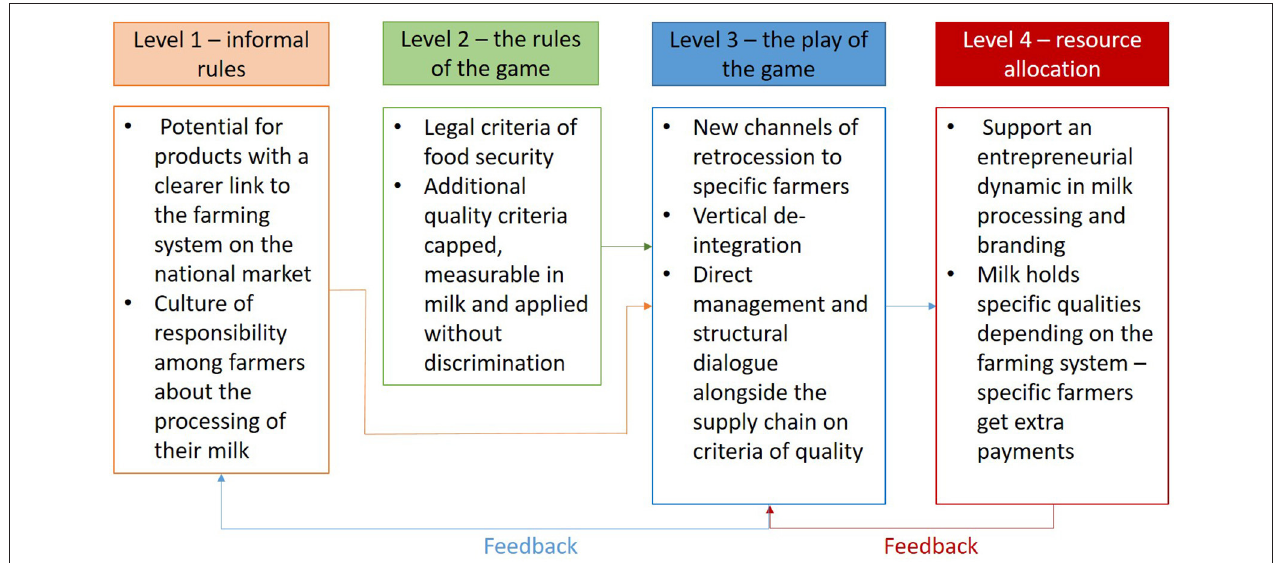
FIGURE 5 | Representation of the coherence of the new cooperative models within Williamson’s